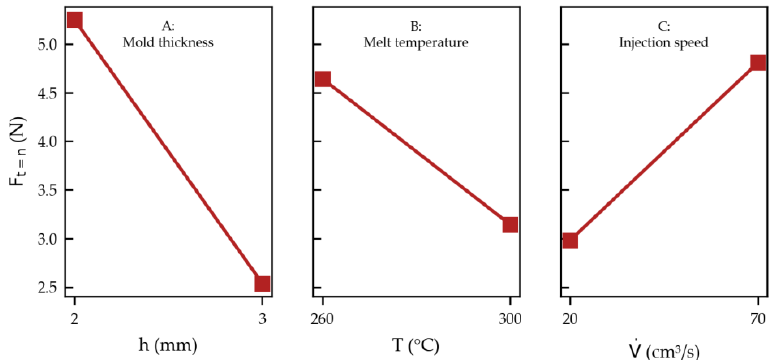
Figure 12. Effect plot for F t = n according to Equation (1).